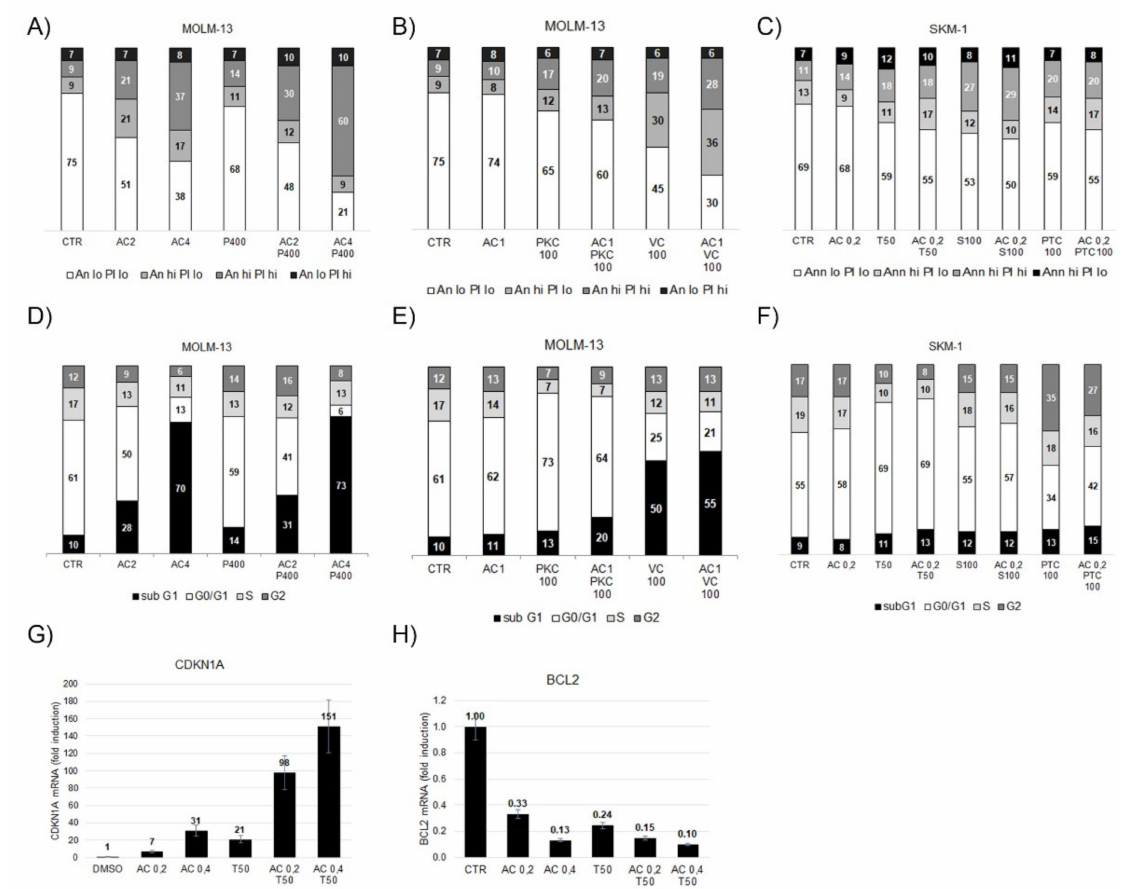
Figure 4. Induction of apoptosis and cell death in AML cells treated with AC-4-130 alone and in combination with targeted compounds. Cytometric analysis of MOLM-13 cells treated for 20 h with AC-4-130 alone and in combination with PTC596 ( A , D ), PKC412 or venetoclax ( B , E ) to measure induction of apoptosis using annexinV and PI staining ( A , B ), and induction of cell-cycle arrest and cell death (subG1 fraction) using DAPI staining ( B , E ). Cytometric analysis of SKM-1 cells treated for 20 h with AC-4-130 (AC) alone and in combination with trametinib (T), S63845 (S), or PTC596 to measure induction of apoptosis using annexinV and PI staining ( C ), and induction of cell-cycle arrest and cell death (subG1 fraction) using DAPI staining ( F ). Relative quantitation of STAT5A target genes CDKN1A and BCL2 in SKM-1 cells treated for 20 hours with AC-4-130 and trametinib ( G , H ). Concentrations of inhibitors were nM for PKC412 (PKC), PTC596 (P), S63845 (S), trametinib (T), and venetoclax (VC), and uM for AC-4-130 (AC). Cells were grouped into four categories each: low- and high-intensity signal in Annexin staining (Ann lo, Ann hi), and low- and high-intensity signal in PI staining (PI lo, PI hi). DNA content in DAPI staining < 2n, 2n, >2n, 4n (subG1, G0/G1, S,